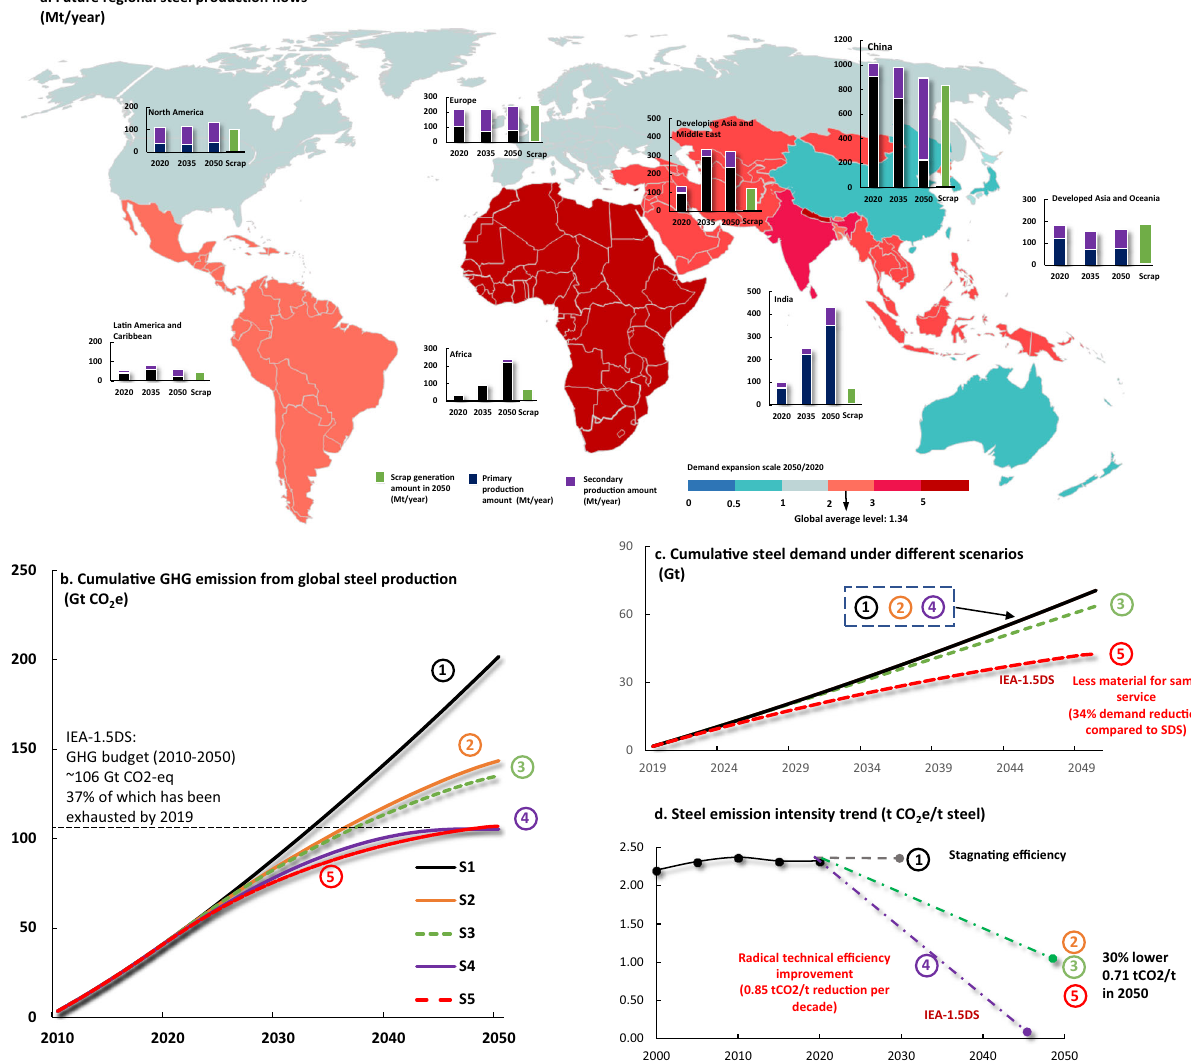
Fig. 5 Feasibility of material and technical ef fi ciency improvement scenarios to avoid the exhaustion of steel-related 1.5DS carbon budgets. Scenarios are intended to represent explorative estimations rather than actual projections, and their settings are given in Supplementary Information 1 Section S4.4. a The regional growth of steel production fl ows from primary and secondary production routes (obtained from IEA Stated Policy Scenario (SPS) from its latest steel report 31 ) and scrap generation (our calculation of scraps is based on the method from Pauliuk et al. 9 ). We also adopt scenario analysis